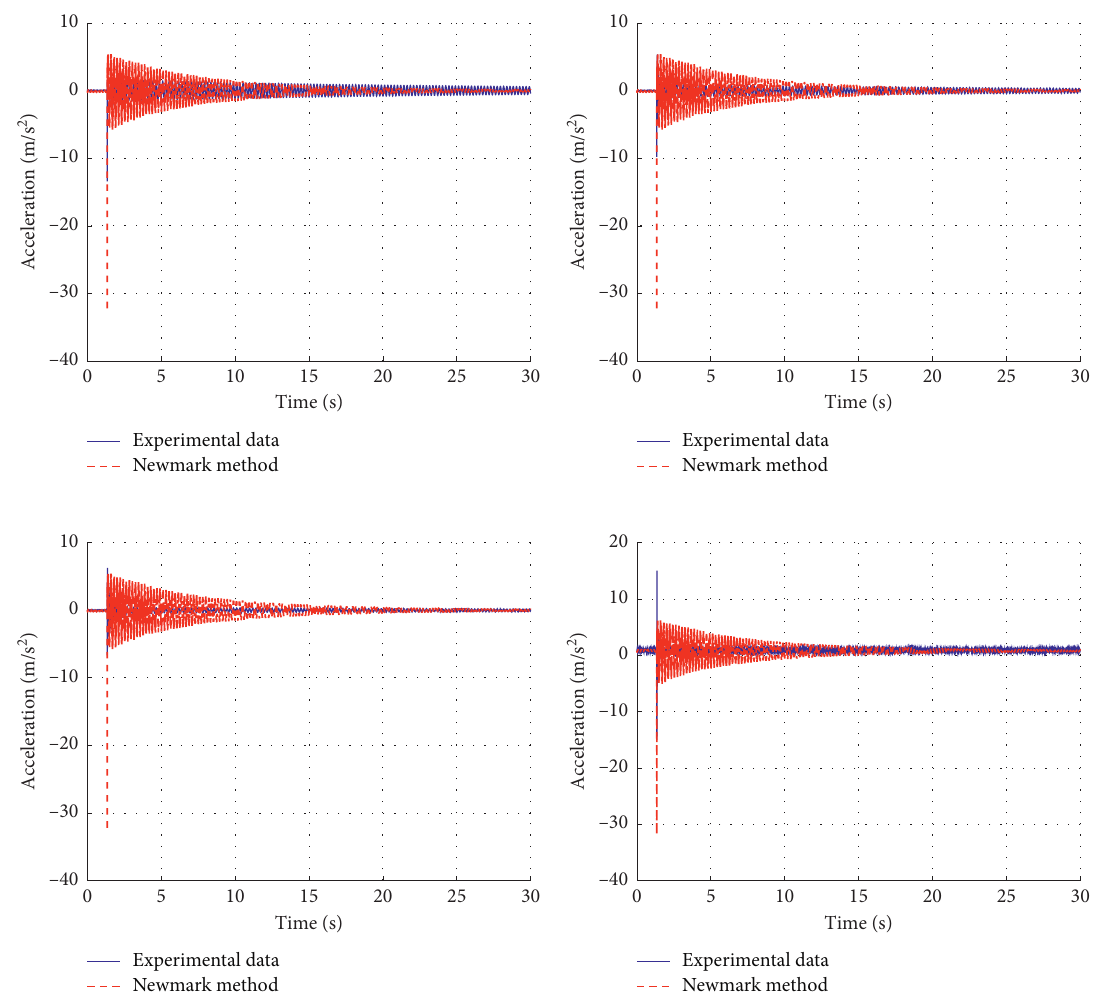
Figure 11: Comparison of numerical and experimental accelerations of the beam at stations 1–4 (CH1, CH2, CH3, and CH4) under impact loading at the free